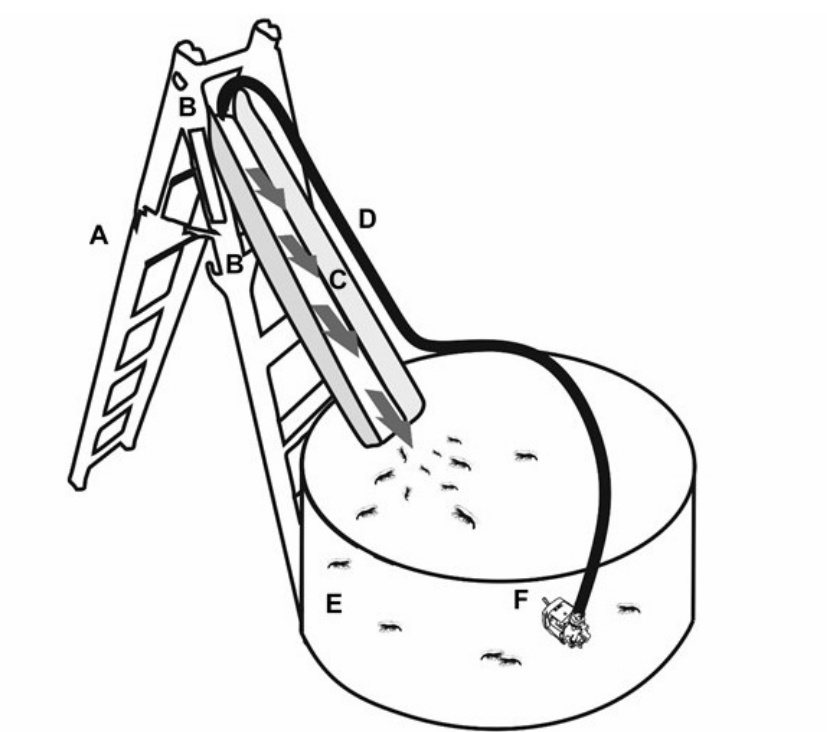
Figure 1. Experimental system used for migratory behavior bioassays of Macrobrachium tenellum juveniles. ( A ) support structure; ( B ) supports to adjust inclination; ( C ) galvanized metal channel with internal gutter of 10 cm; ( D ) water flow conducting hose; ( E ) circular tank, capacity 400 L with V cut; ( F ) submersible